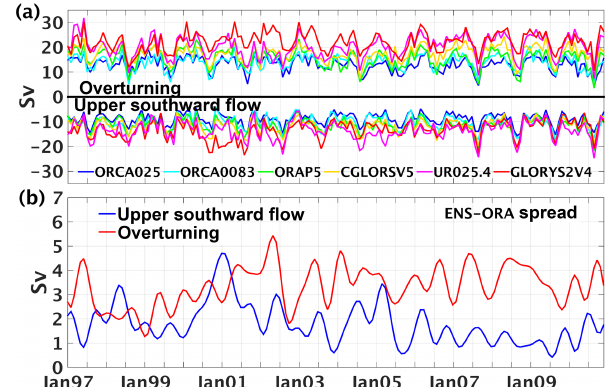
Figure 13. (a) Monthly time series of ψ max (Sv) and the maximum upper southward flow (Sv) for each product calculated as an average from 15 ◦ S to the Equator and (b) their ENS-ORA spreads (Sv). A running mean of 6 months was applied to smooth the ENS-ORA spread time series. The upper southward flow is calculated using the same approach as in Fig.